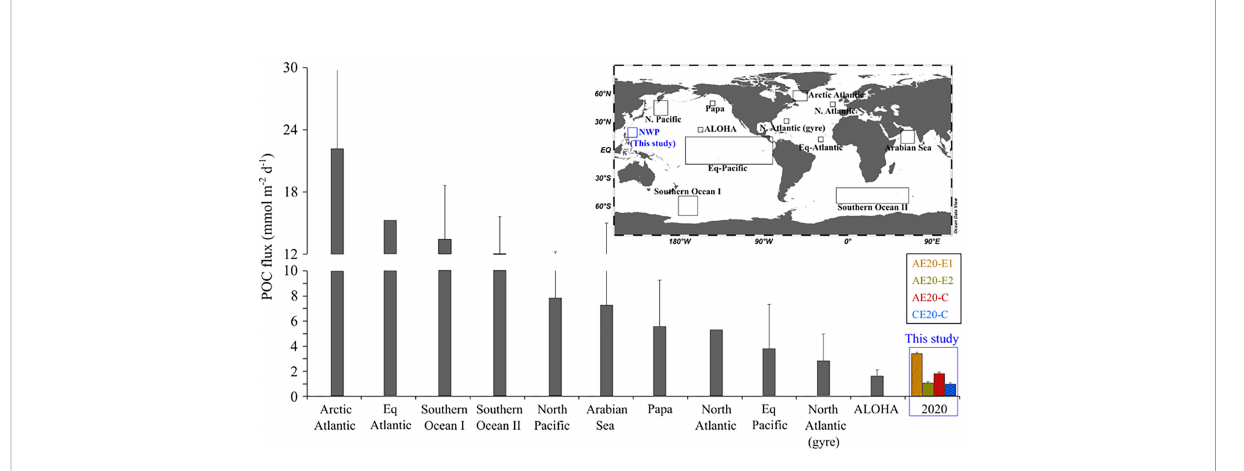
FIGURE 6 Distribution of 234 Th-derived POC fl uxes in the ocean. The boxes in the inset indicate the study regions. The data for comparison are from Moran et al. (2003) for the arctic Atlantic, Thomalla et al. (2008) for the equatorial Atlantic and the North Atlantic, Buesseler et al., 2003; Buesseler et al. (2001) for the Southern Ocean I, Rutgers van der Loeff et al. (1997) and Morris et al. (2007) for the Southern Ocean II, Kawakami and Honda (2007) for the North Paci fi c, Buesseler et al. (1998) for the Arabian Sea, Buesseler et al. (2020) for Station Papa, Buesseler et al. (1995) and Murray et al. (1996) for the equatorial Paci fi c, Buesseler et al. (2008) for the North Atlantic (gyre), and Buesseler et al. (2009b) for Station